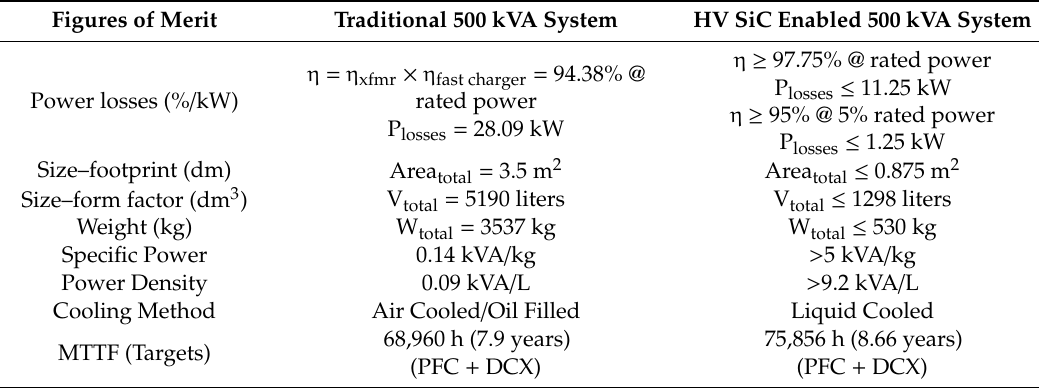
Table 1. Comparison of Metrics for a Traditional and Proposed 500 kVA Fast Charging